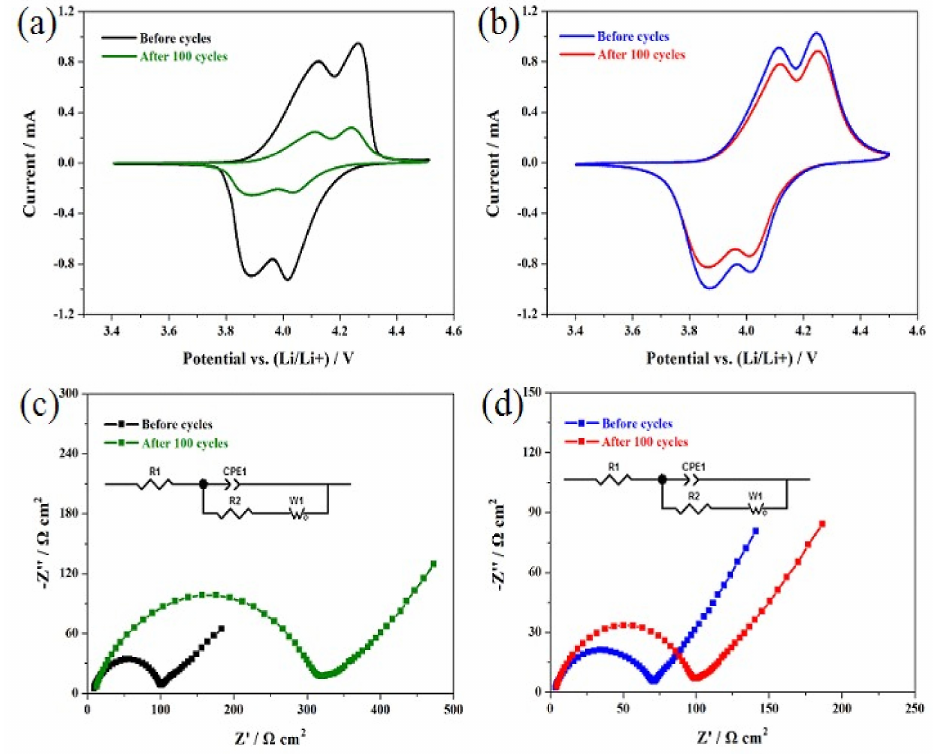
Figure 7. Cyclic voltammogram curves of the LiMn 2 O 4 ( a ) and LiSi 0.05 Mn 1.95 O 4 ( b ) samples at a scan rate of 0.15 mV s − 1 ; Nyquist plots of the LiMn 2 O 4 ( c ) and LiSi 0.05 Mn 1.95 O 4 ( d ) samples before cycling and after 100 cycles.